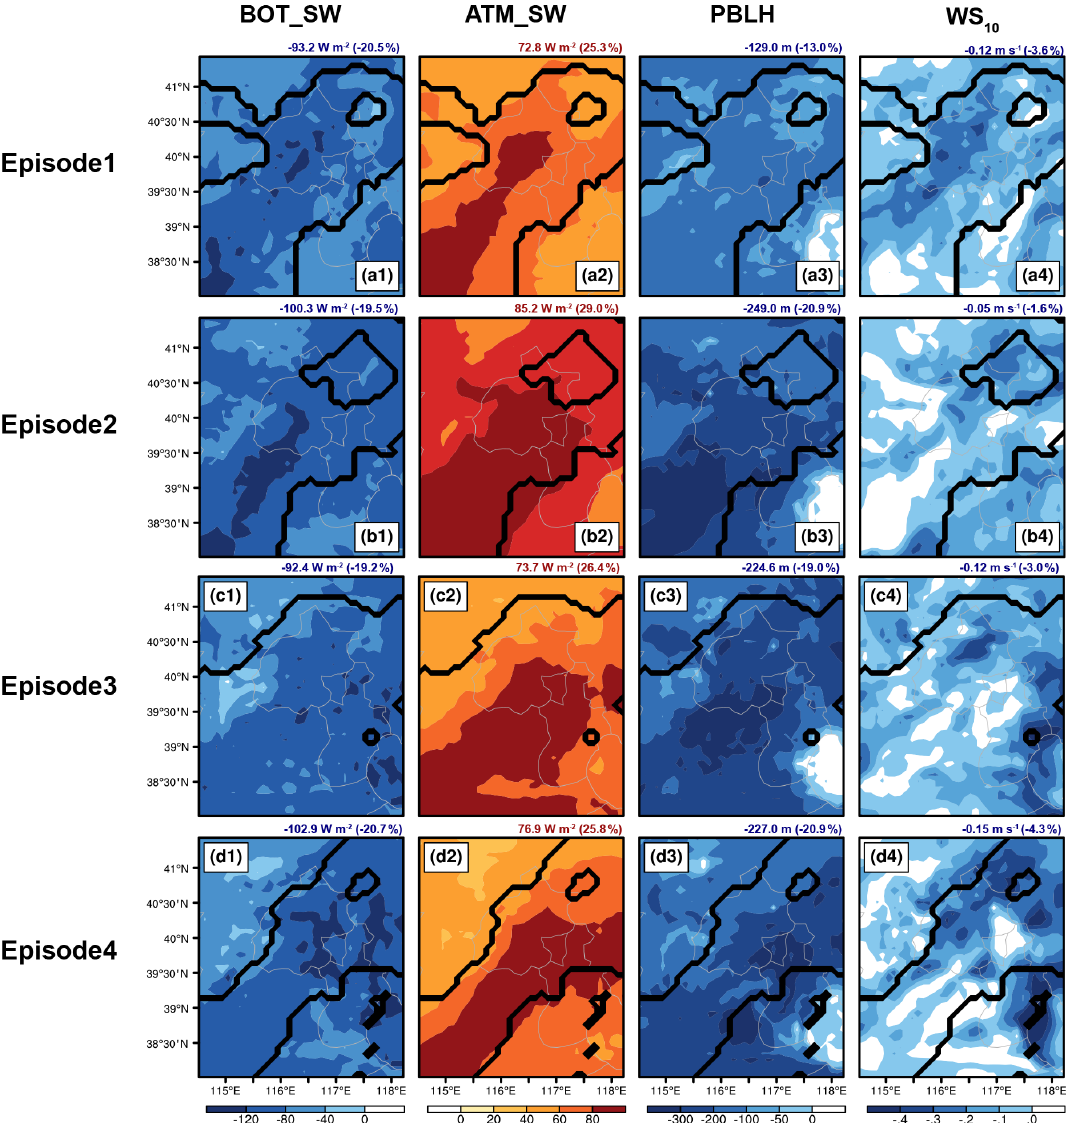
Figure 4. The impacts of aerosol–radiation interactions on shortwave radiation at the surface (BOT_SW), shortwave radiation in the at- mosphere (ATM_SW), PBL height (PBLH), and 10m wind speed (WS 10 ) in the daytime (08:00–17:00LST) during 28 July to 3 August 2014 (Episode1), 8–13 July 2015 (Episode2), 5–11 June 2016 (Episode3), and 28 June to 3 July 2017 (Episode4). The regions sandwiched between two black lines are defined as the complex air pollution areas (CAPAs), where the mean daily PM 2 . 5 and MDA8 O 3 concentrations in the BASE case are larger than 75µgm − 3 and 80ppb. The calculated changes (percentage changes) averaged over CAPAs are also shown at the top of each